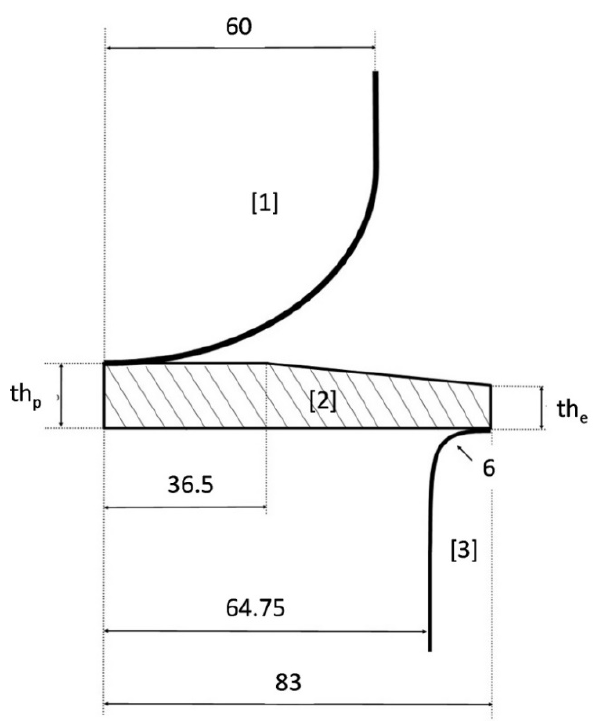
Figure 1. Scheme of the axisymmetric stretching on a sheet with an initial variable thickness (1 is the punch, 2 is the blank and 3 is the